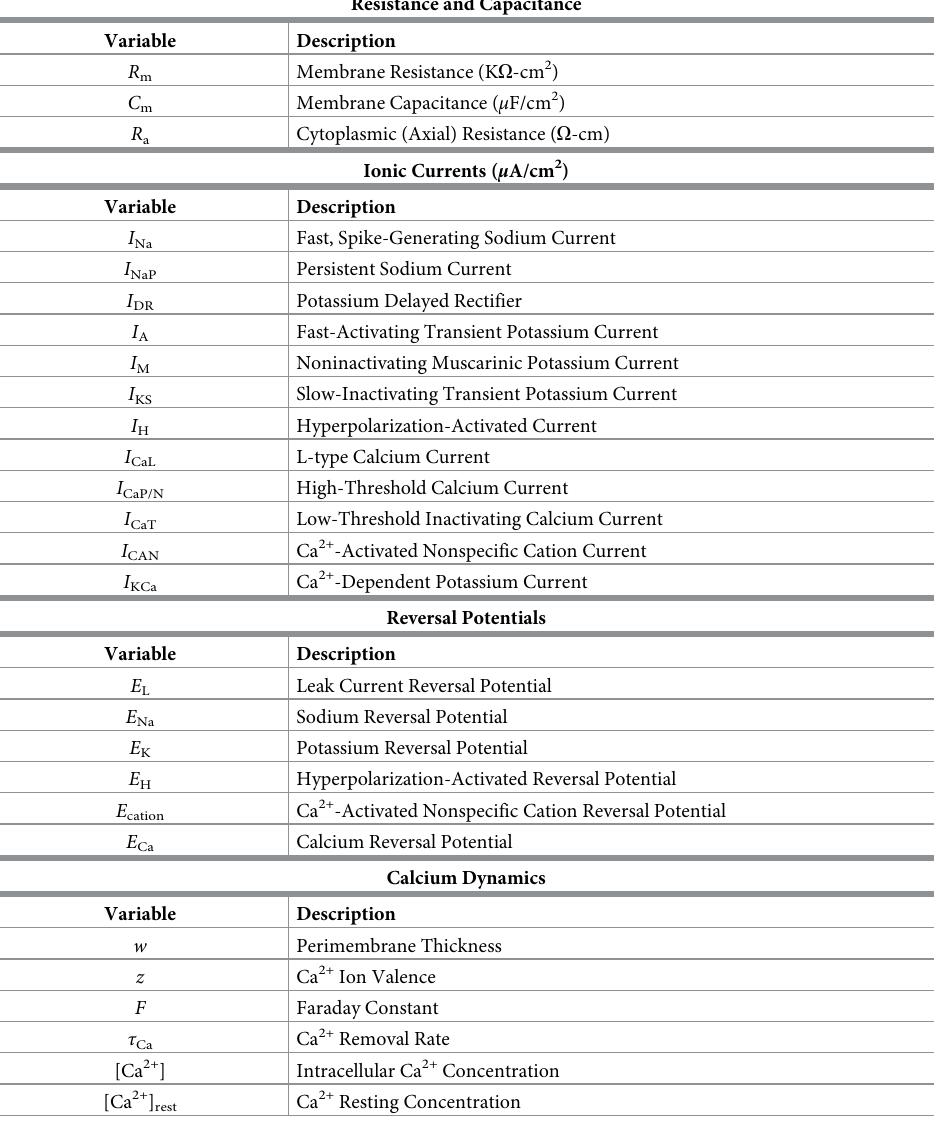
Table 3. Description of model